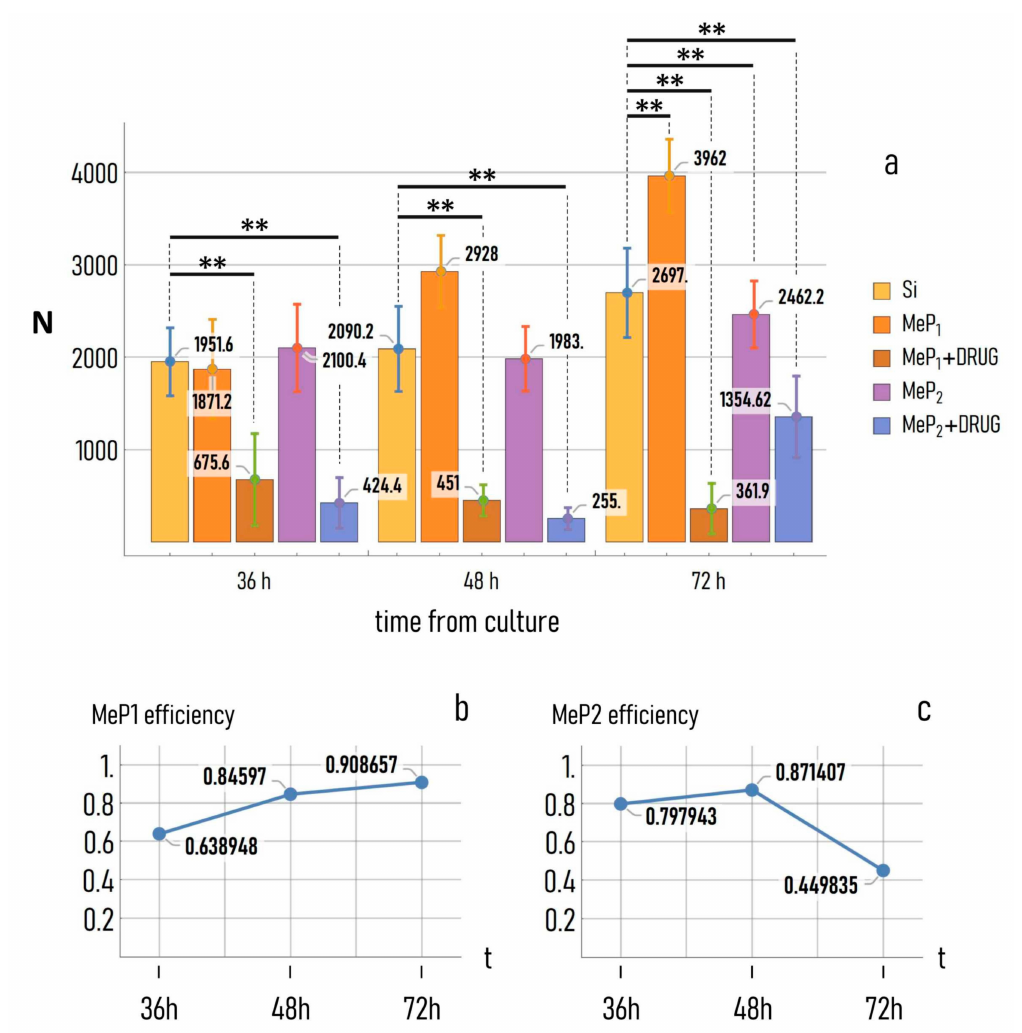
Figure 9. ( a ) Number of adhering cells on Au-MeP 1 and Au-MeP 2 substrates under and without the influence of the antitumor agent PtCl(O,O (cid:48) -acac)(DMSO), at 36, 48, and 72 h from cell seeding, compared to plain silicon used as a control. All p values less than 0.05 are summarized with two asterisks. E ffi cacy of the antitumor drug on the cancer cells at di ff erent times from the initial release, for the ( b ) Au-MeP 1 ( c ) and Au-MeP 2